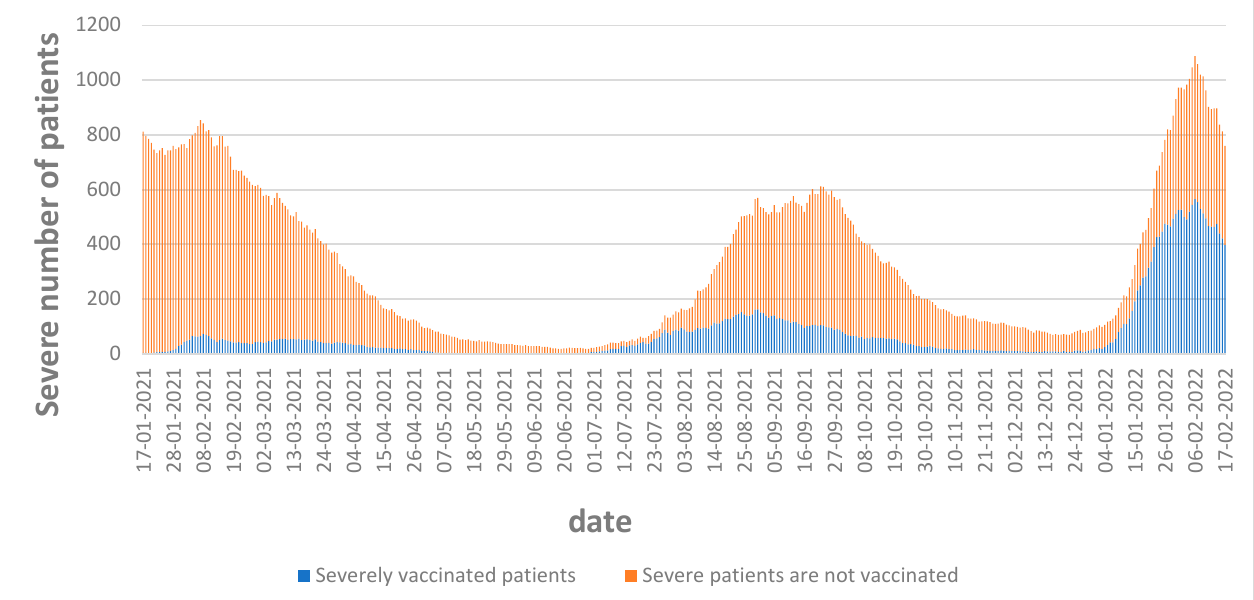
Severely vaccinated patients Severe patients are not vaccinated Figure 3. Severely ill vaccinated versus unvaccinated people.